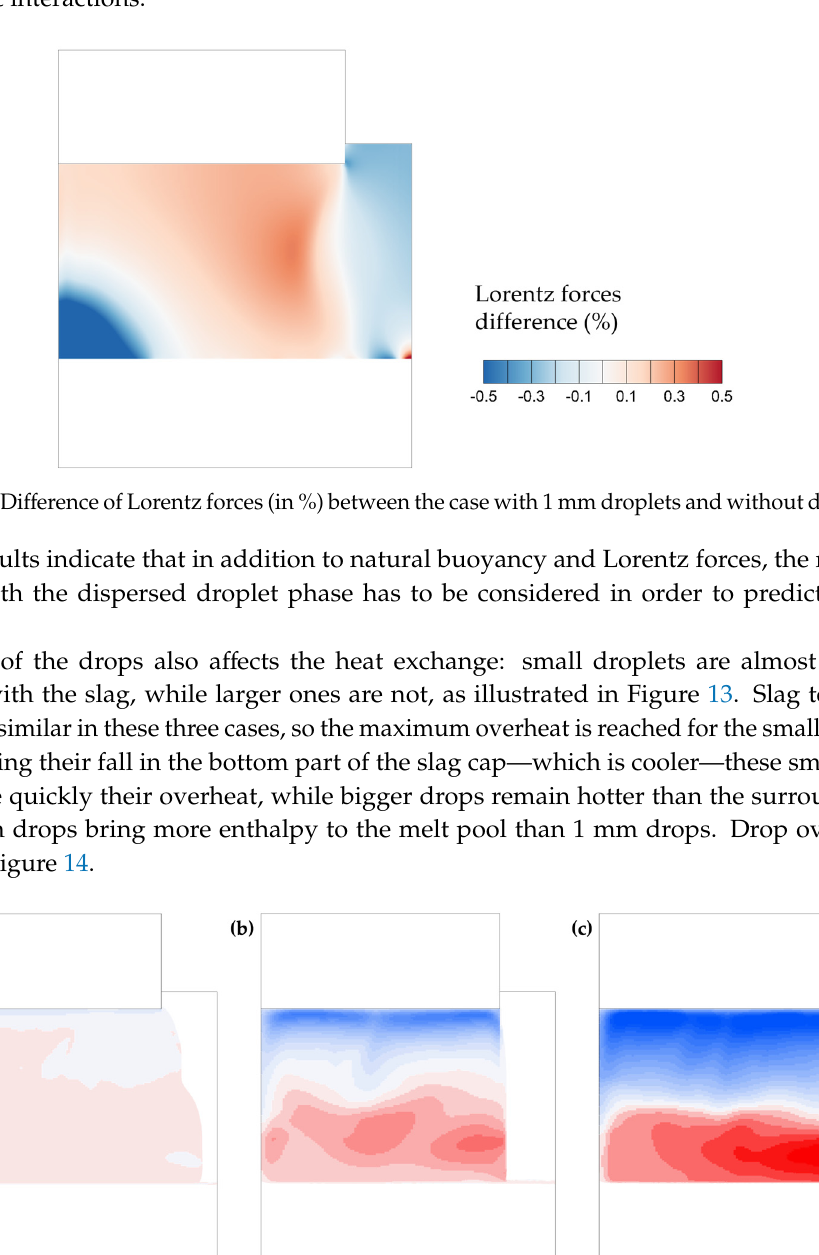
Figure 11. Slag phase velocity magnitude and normalized slag velocity vectors (time-averaged) considering the fall of 1 mm ( a ), 5 mm ( b ) and 10 mm ( c ) drops.